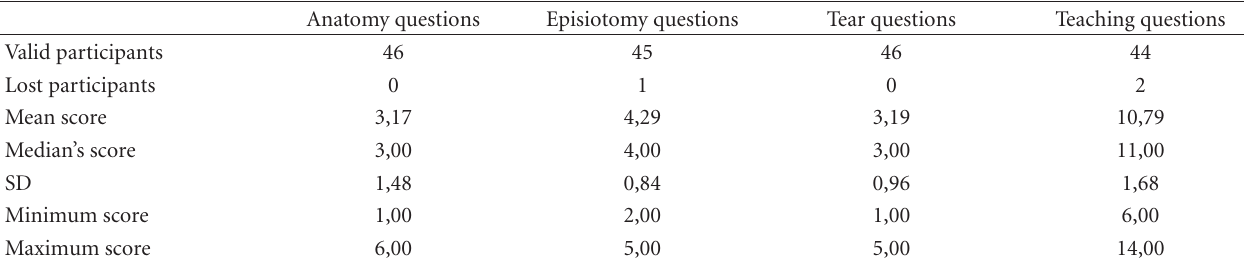
Table 2: Aggregate index rates calculated for each block of questions. Higher scores indicate better results.